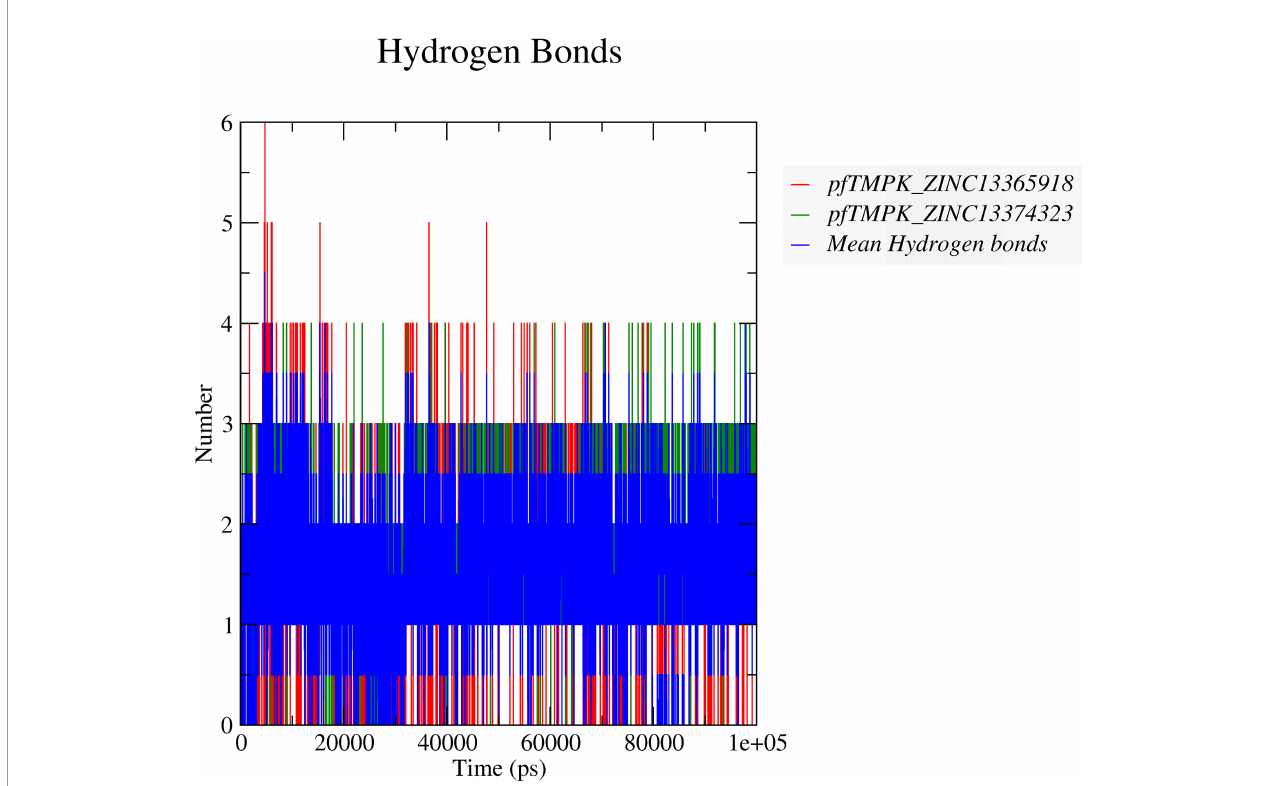
FIGURE 6 | Hydrogen bond predictions between the complexes of Pf TMPK and the respective potential lead compounds. The hydrogen bonds formed between Pf TMPK and ZINC13365918 are shown as red lines, while those of the protein and ZINC13374323 are shown as green lines. The mean hydrogen bonds formed throughout the simulation in both complexes are highlighted in